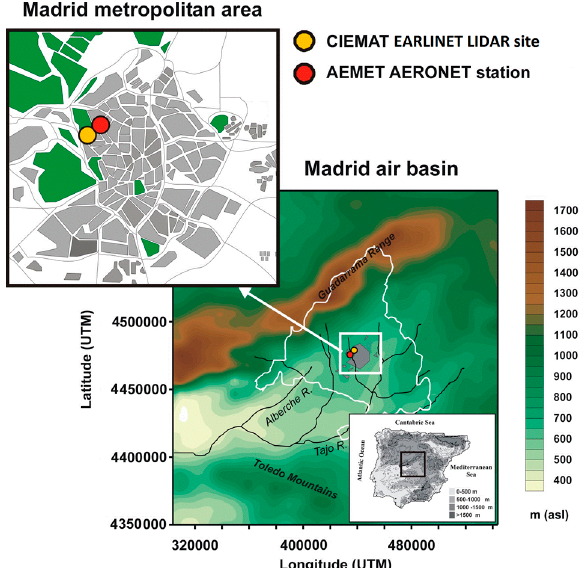
Figure 1. Geographical location of the EARLINET lidar site (yellow point) and the Madrid AERONET station (red point) with respect to the metropolitan area.